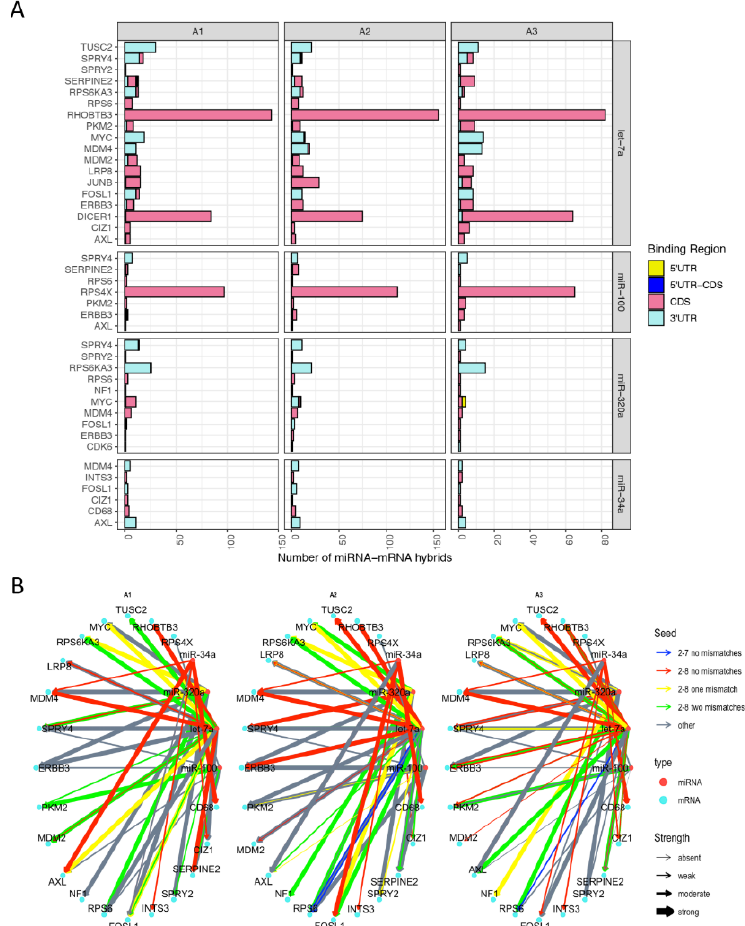
Figure 6. Selected miRNA-mRNA hybrids. ( A ) Selected mRNA targets (left y -axis) of let-7a, miR- 34a, miR-100, and miR-320a (right y -axis) with number of occurrences ( x -axis) and the binding region across three biological replicates. ( B ) Networks of miRNA (red dots) and mRNA (blue dots) interactions found in hybrids of A1, A2, and A3 using tidygraph. Arrow color represents the miRNA 5 ′ seed match and arrow thickness corresponds to the strength at the 3 ′ end of the miRNA.